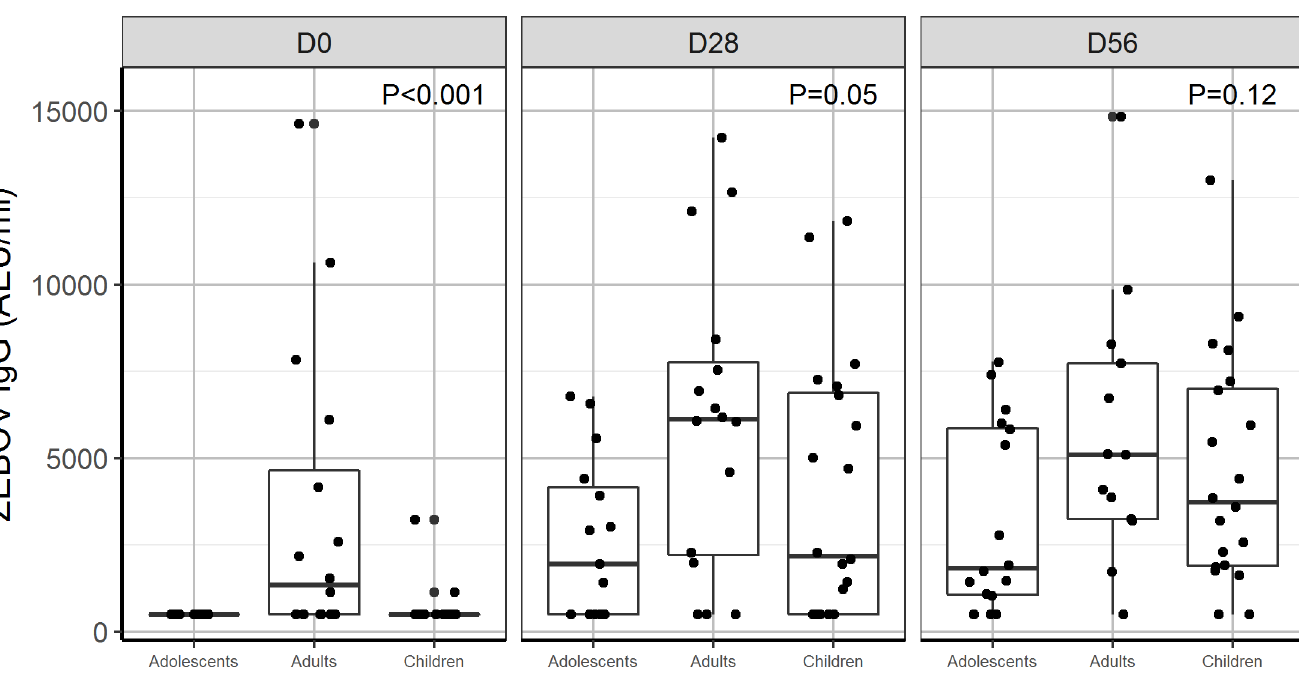
Fig 4. Antibody responses to whole-virion ELISA (AEU/ml) by age group: Comparison of geometric mean concentration of IgG antibodies for children, adolescents, and adults vaccinated with the 2 × 10 7 PFU dose at day 0, 28, and 56. P < 0.05 indicatesa statistical difference in antibody concentrations betweenage groupsat the measuredtime points. AEU, arbitrary enzyme-linked immunosorbent assay units; ELISA, enzyme-linked immunosorbent assay; PFU, plaque-forming units; ZEBOV, Zaire Ebola virus.